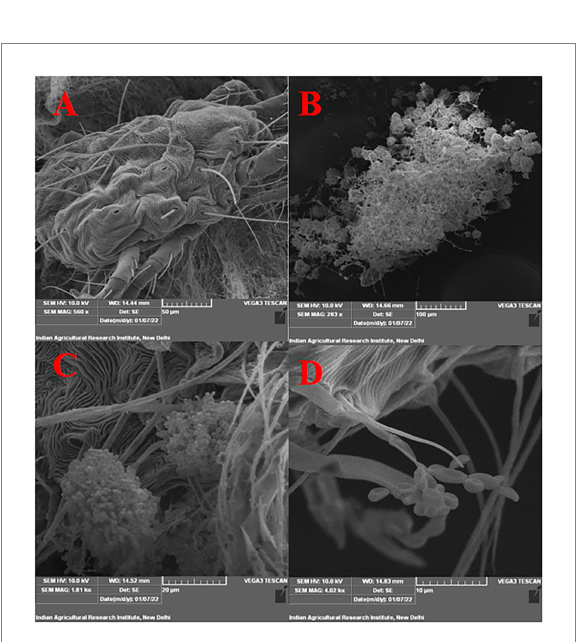
FIGURE 4 Infection confirmation under SEM (A) untreated control (no mortality), (B) growth and sporulation of B. bassiana on dead T. truncatus under 100 μ m scale, (C) under 20 μ m scale, (D) under 10 μ m scale (phialides and conidia are